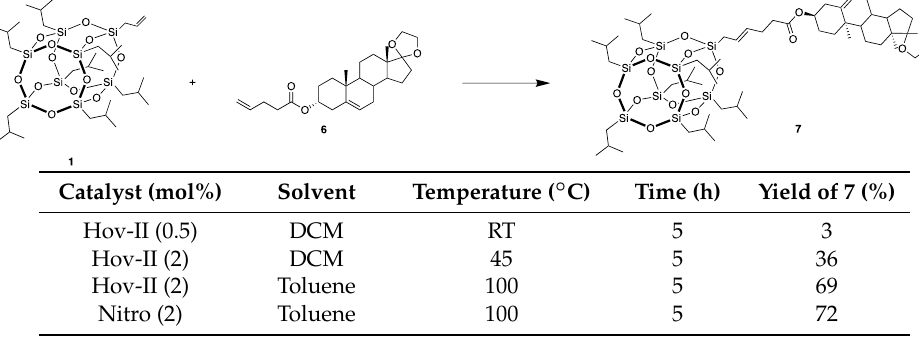
Table 2. Cross metathesis of allyl-POSS 1 with derivative of androsterone 6 .